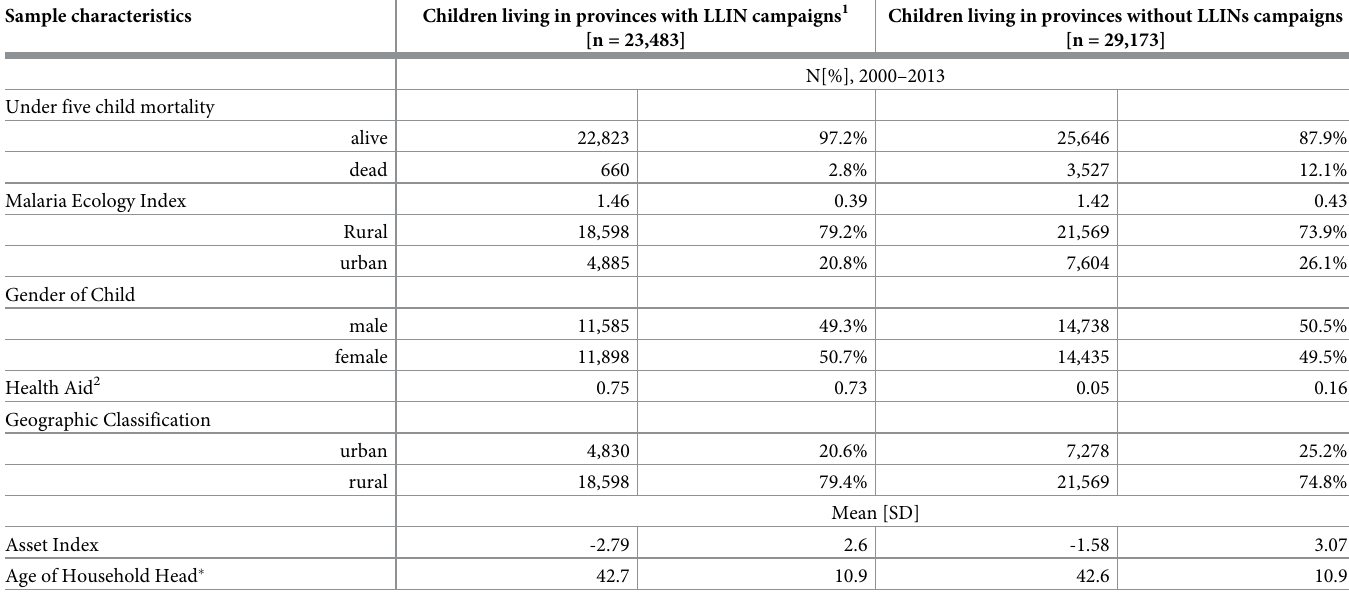
Table 1. Summary table by Long Lasting Insecticidal Nets [LLINs] distribution [n = 52,656 children]. Sample